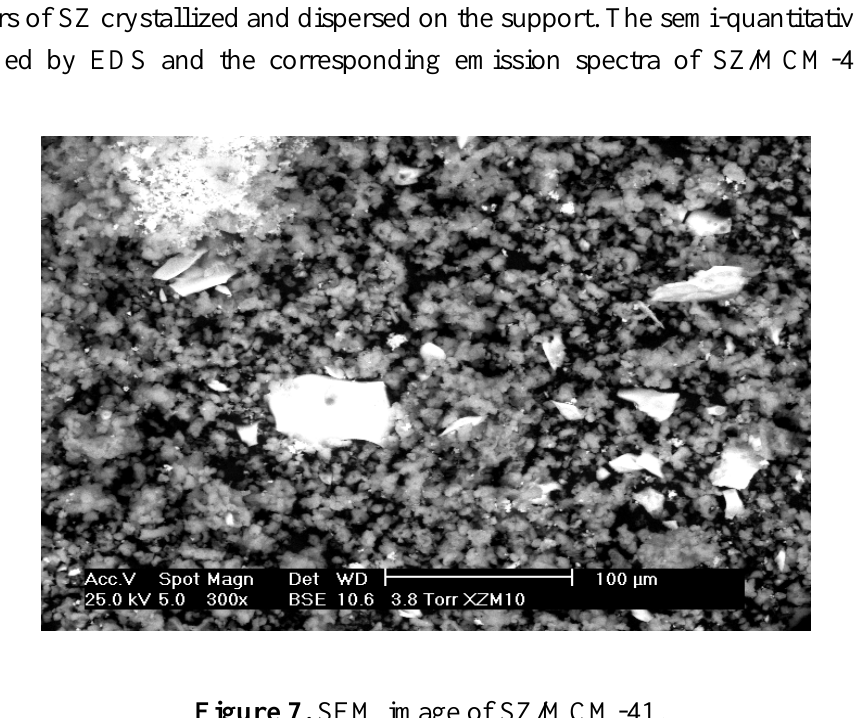
Figure 7. SEM image of SZ/MCM-41.